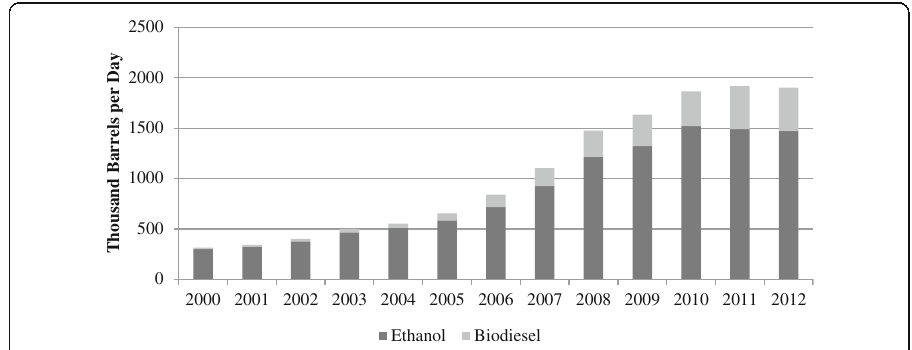
Fig. 6 Global biofuel production. Source: U.S. Energy Information Administration